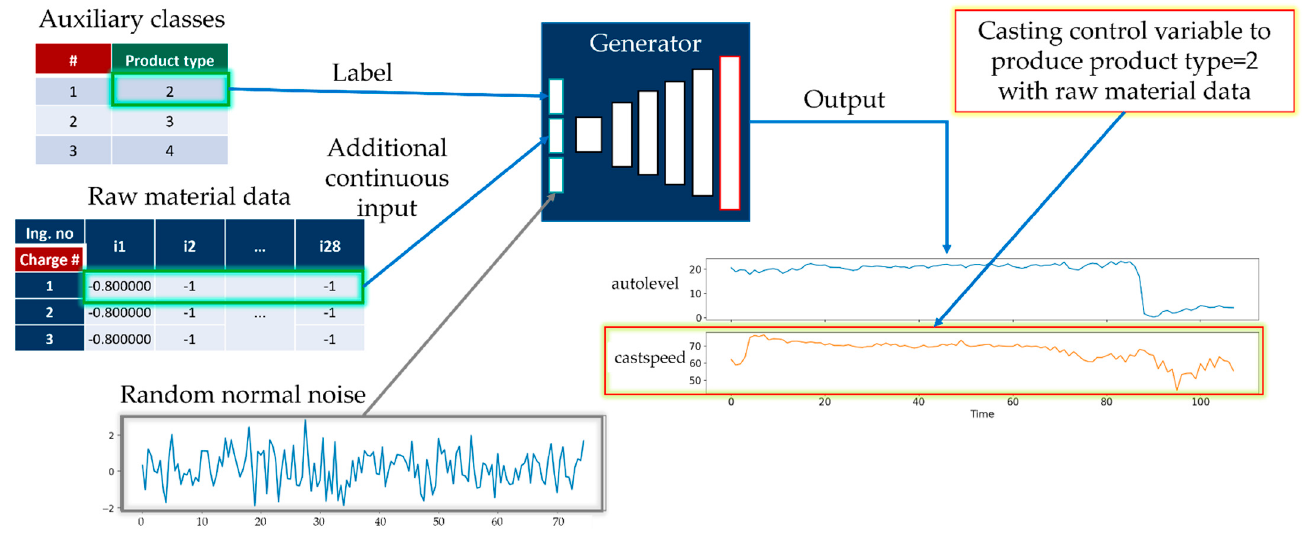
Figure 6. Generator model of AC ‐ GAN for the casting process.